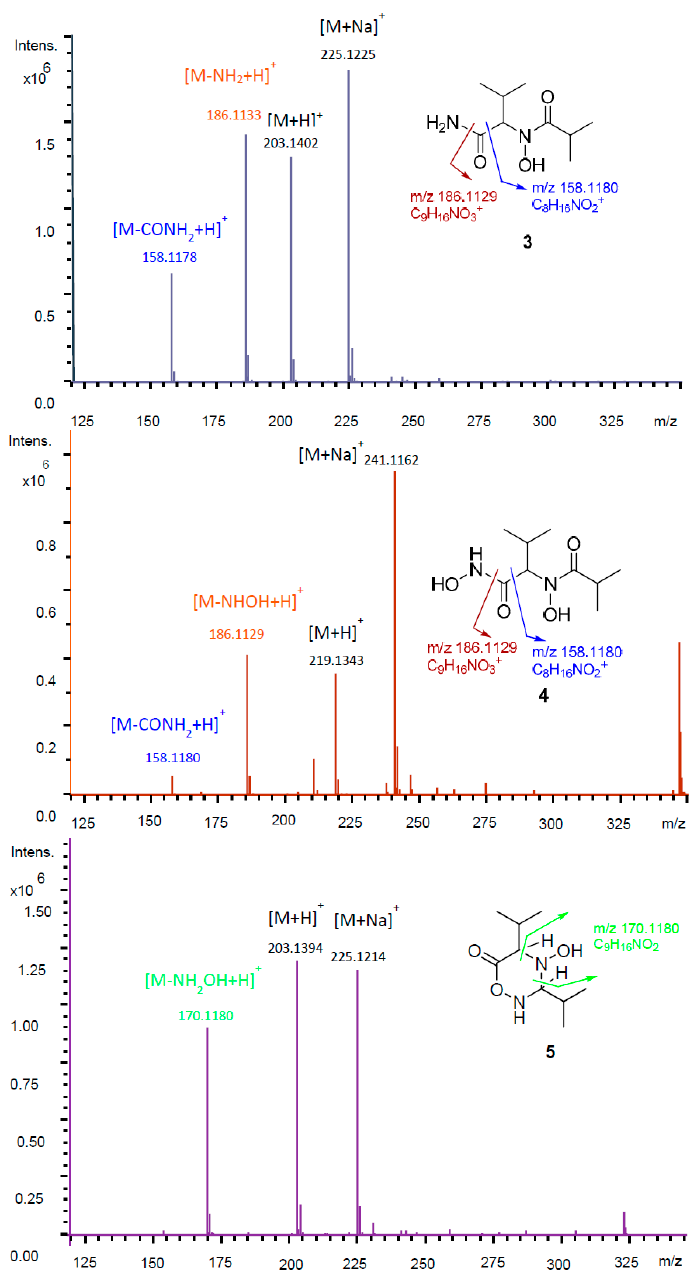
Figure 3. HRMS spectra for Compounds 3 – 5 .